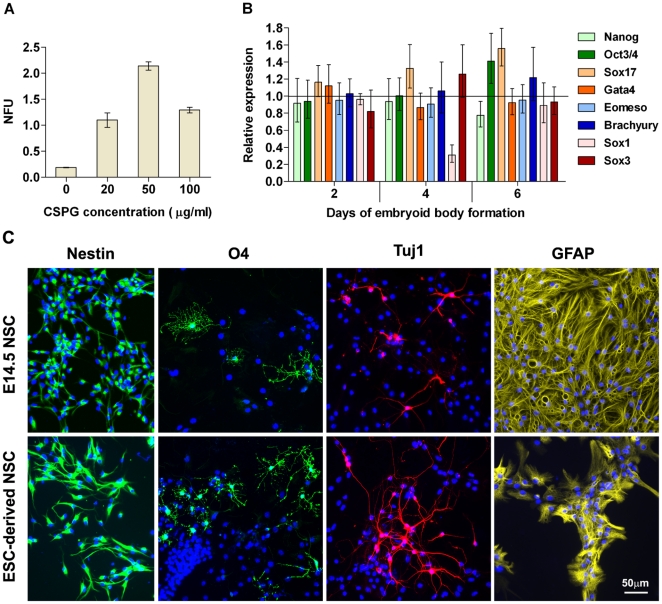
CSPG stimulates nsph formation from ESC.(A) ESC cells were cultured at 105 cells/ml with or without CSPG (20–100 µg/ml) in nsph growth medium and NFUs measured after 21 days. Data are presented as mean ± SEM with n≥3 (from 1 representative experiment). Similar results were obtained in two other experiments. (B) Expression analysis of pluripotency genes (Nanog and Oct3/4), endoderm genes (Sox17 and Gata4), mesoderm genes (Eomeso and Brachyury) and ectoderm genes (Sox1 and Sox3) was measured by quantitative RT-PCR as described in the supplementary Materials and Methods S1. The bar chart shows CSPG (50 µg/ml) induced changes in gene expression relative to control with a value of 1 indicating no change. Data are presented as mean ± 95% confidence interval with n = 8 (from 4 experiments). (C) Undifferentiated ESC-derived nsphs and E14.5 nsphs were stained for nestin. Both types of nsphs were dissociated for differentiation and stained for lineage markers as described in figure 4 and the supplementary Materials and Methods S1. Scale bar  = 50 µm at 20X objective.